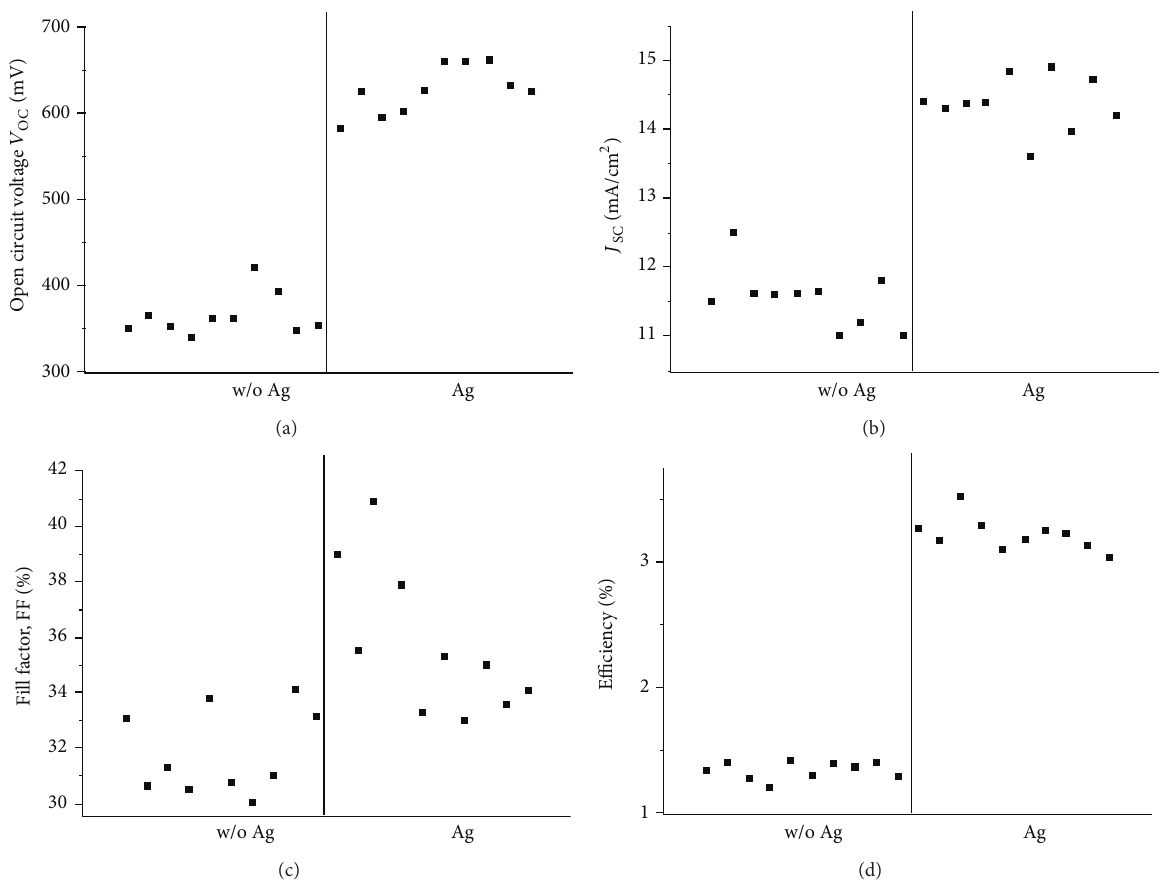
Figure 3: IV parameters of 10 CZTS solar cells each from the sample with and without the Ag intermediate layer: (a) open circuit voltage ); (b) short circuit current density ( 𝐽 ); (c) fill factor (FF); and (d) efficiency. ( 𝑉 OC SC